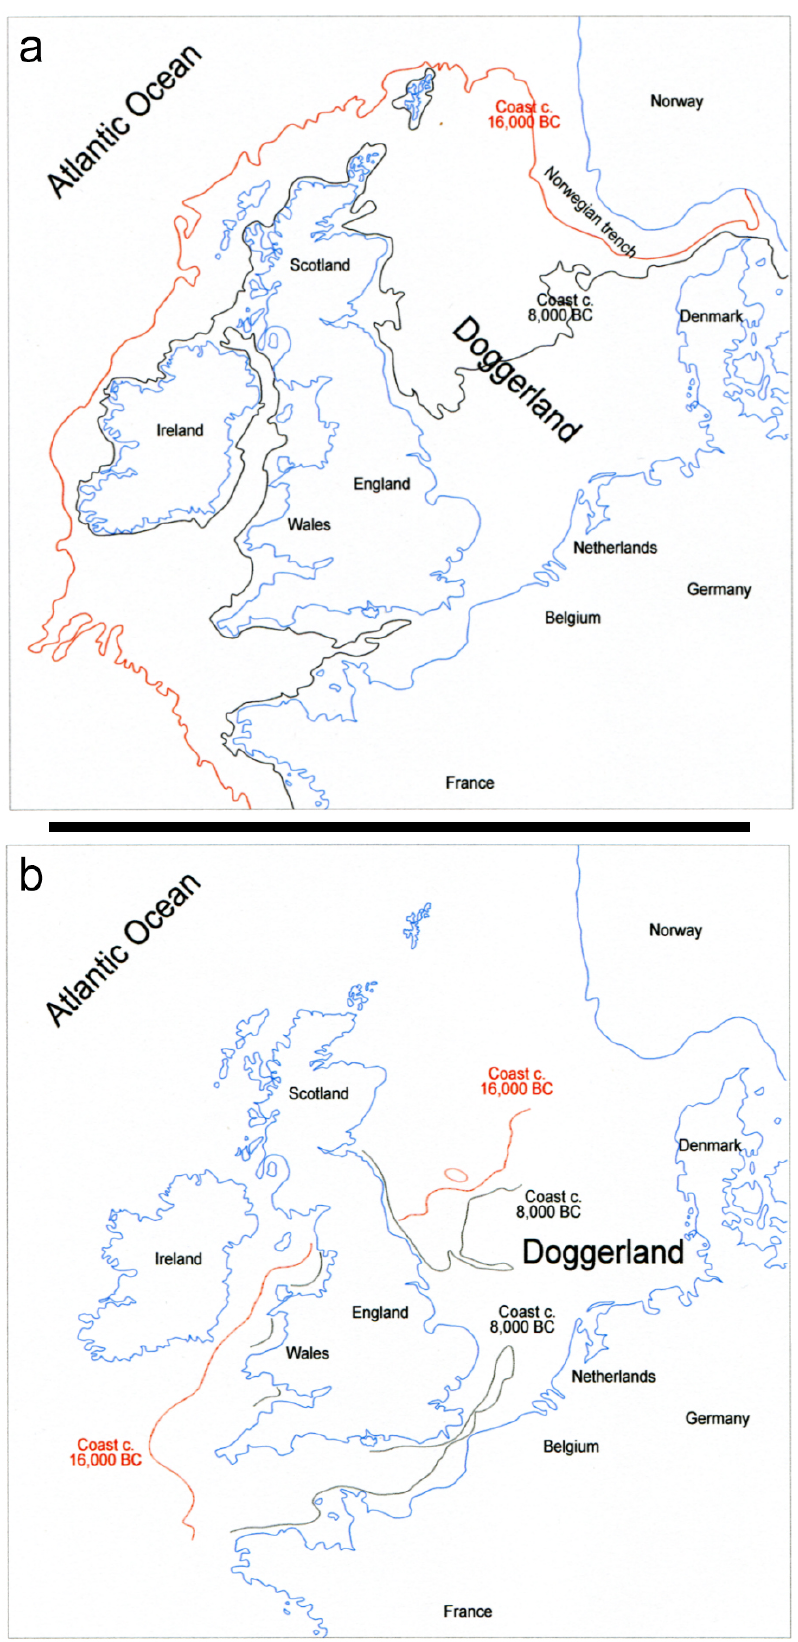
Figure 9. Maps of Doggerland, showing the staged retreat of the Doggerland coastlines, at c. 16,000 BCE and c. 8,000 BCE. a) According to Spinney (2012). b) according to Brooks et al. (2011) and Sturt et al. (2013). The red lines indicate the coast around 16,000 BCE, and the black lines around 8,000